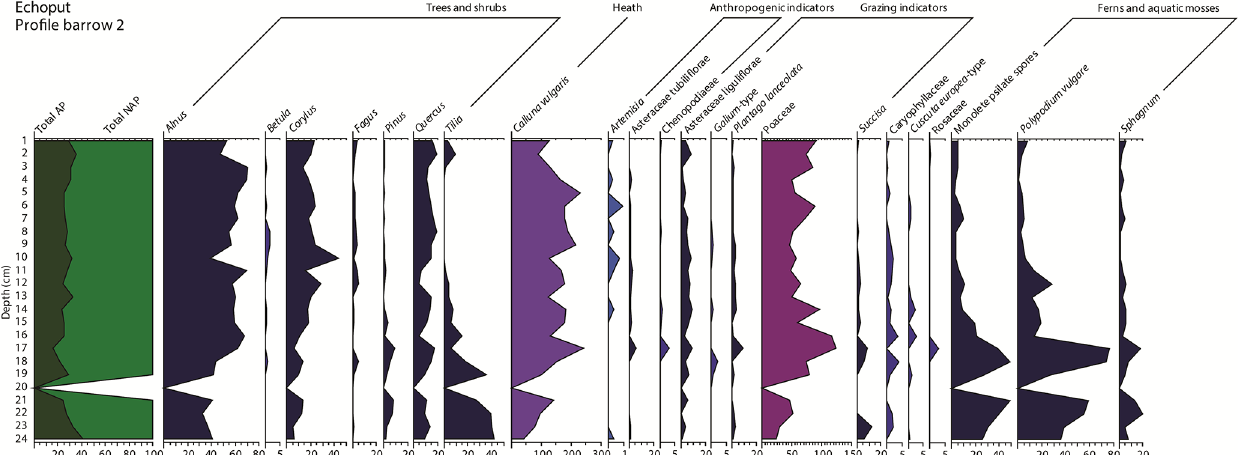
Figure 10. Pollen diagrams derived from the series of samples taken from underneath Echoput barrow 2.